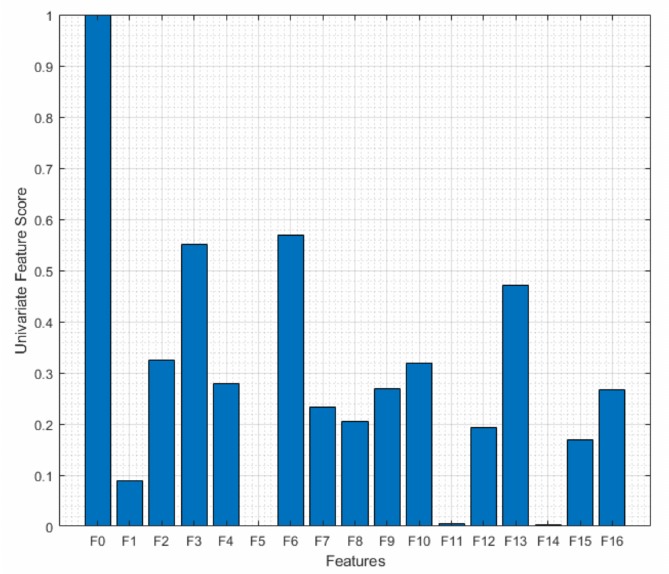
Figure 2. Univariate feature scores of the futures. The bar chart shows the informative and non- informative features. The most informative features are F0, F6, and F3 and the least informative features are F5, F11, and F14.